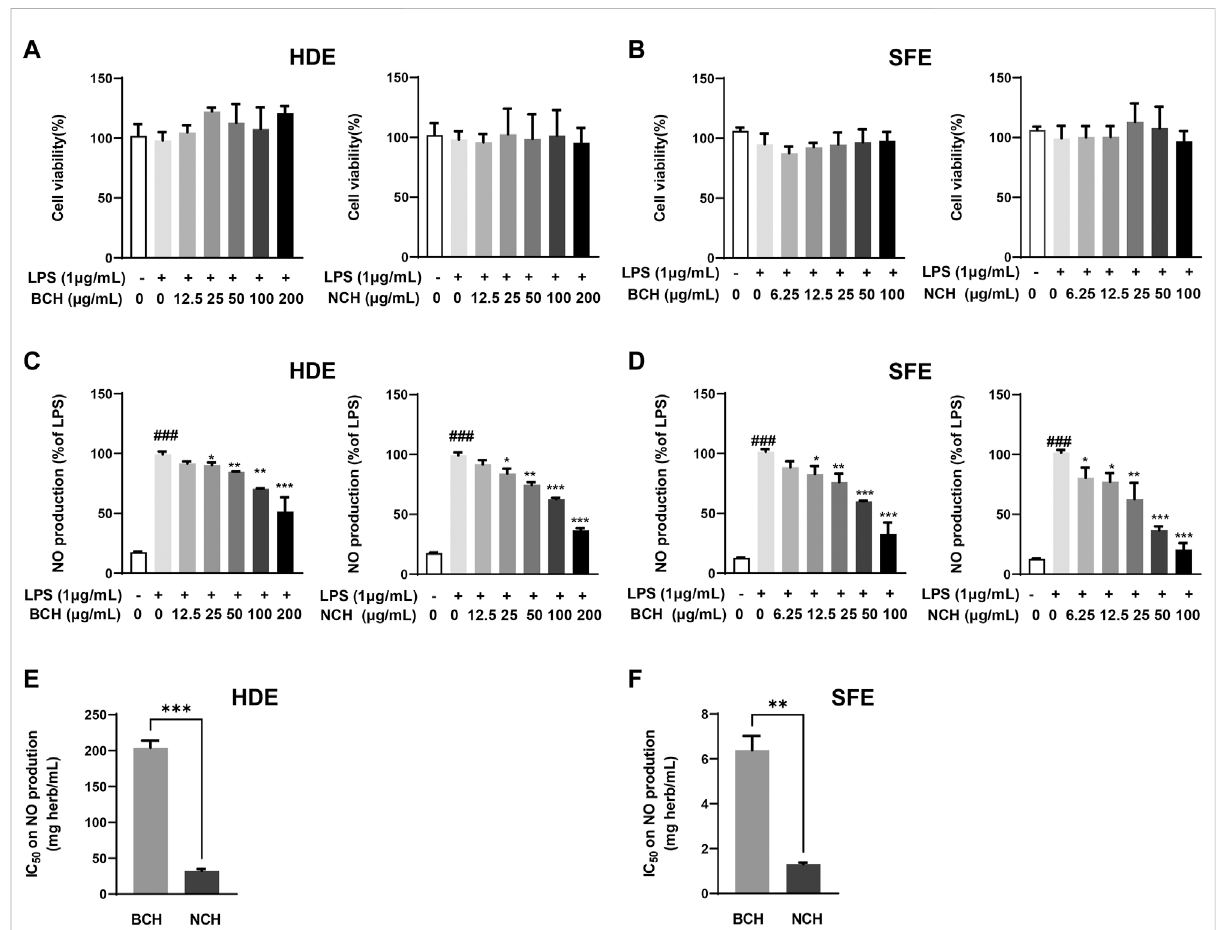
The anti-in fl ammation activity of HDE and SFE from BCH and NCH on RAW264.7 cells. (A) Cytotoxicity of HDE from BCH and NCH on RAW264.7cells; (B) cytotoxicityofSFEfromBCHandNCHonRAW264.7cells; (C) anti-in fl ammatoryeffectsofHDEfromBCHandNCHthroughthe measurementof accumulated nitrite; (D) anti-in fl ammatory effects of SFE from BCH and NCH through themeasurement of accumulated nitrite; (E)